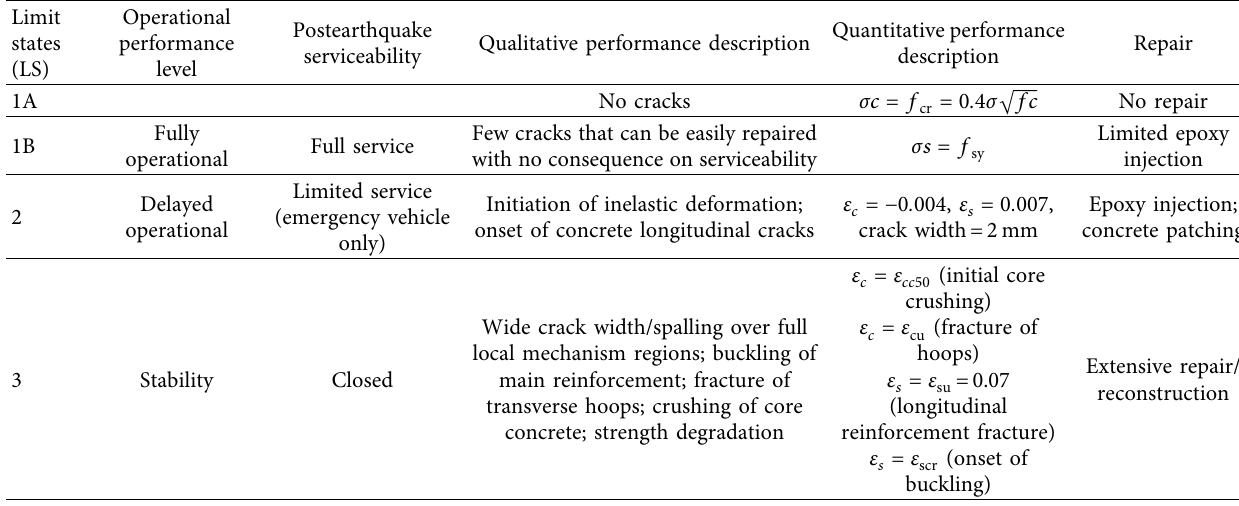
Table 2: Qualitative and quantitative performance levels correlated with engineering parameters and repair techniques [27,